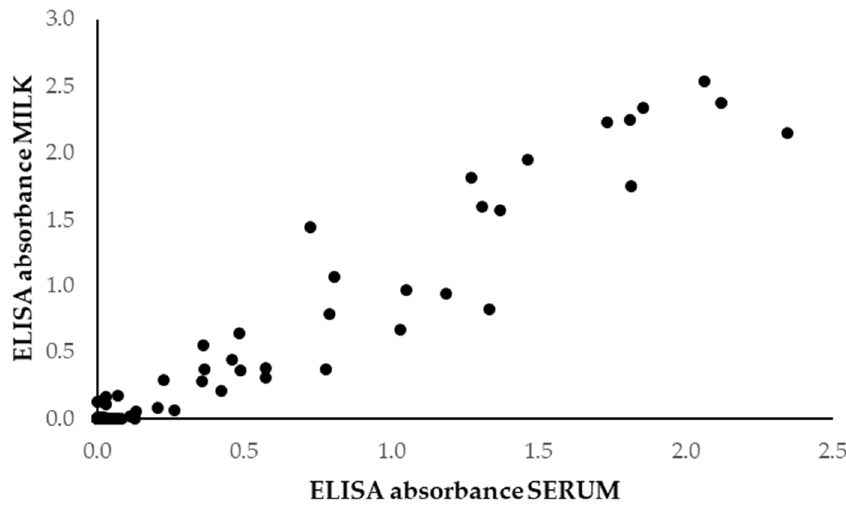
Figure 1. CAE-ELISA absorbance values in serum ( x -axis) vs. milk ( y -axis) in 212 lactating goats included in the study to estimate the occurrence of CAE and CLA (Sweden, 2018).